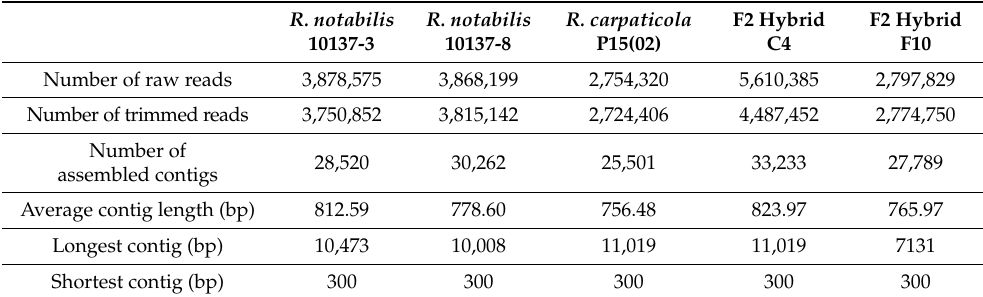
Table 1. Summary of Illumina sequencing, quality control of reads, and assembly for the five Ranunculus samples herein.